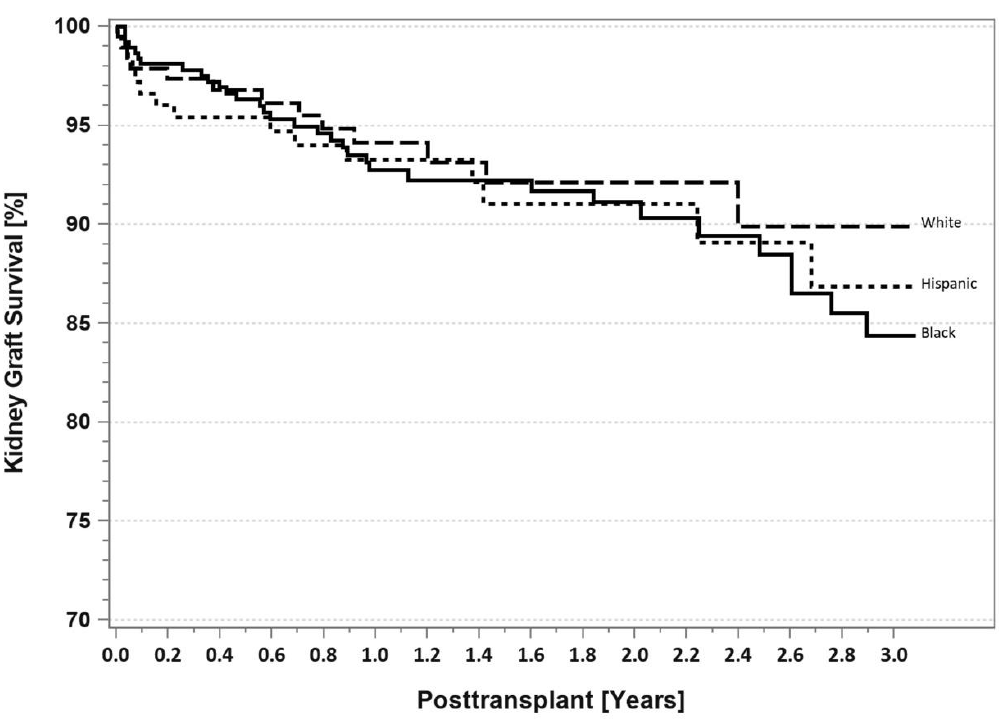
Figure 14. SPKT kidney graft survival according to recipient race in patients identified as having T2DM in the latest era (1 January 2017 – 31 December 2021).